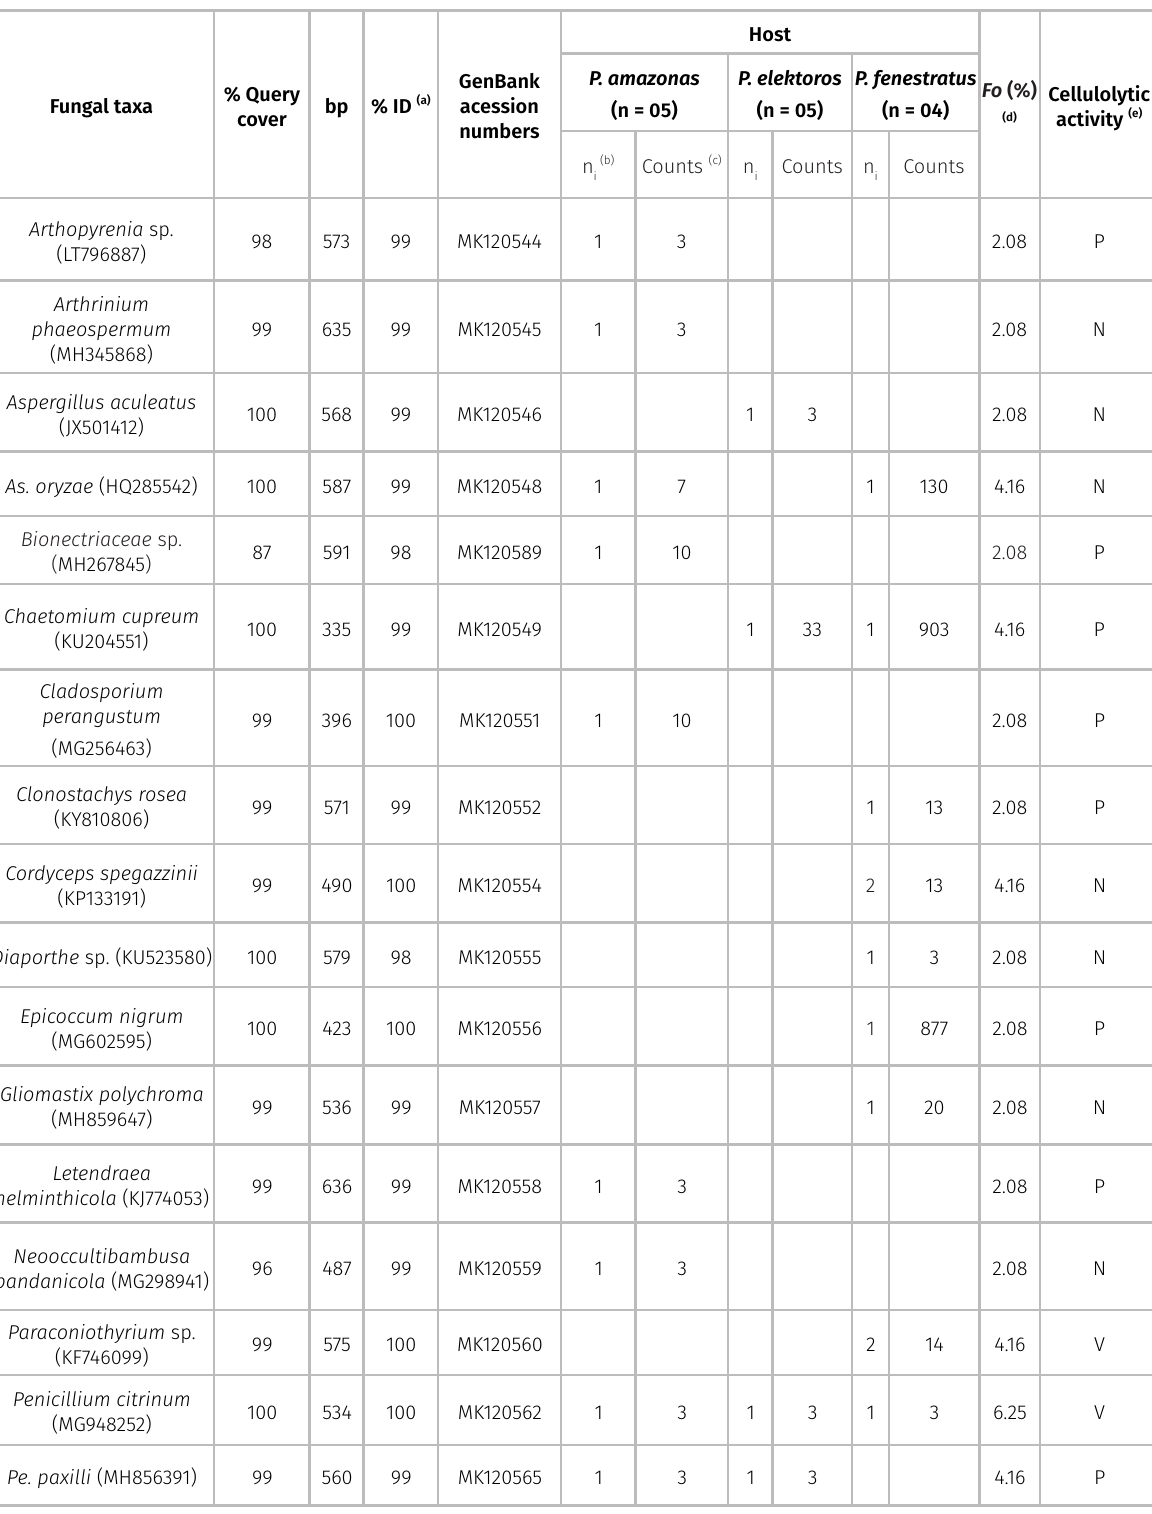
Table I. Identification, frequency of occurrence ( Fo ) and cellulolytic activity of fungal taxa isolated from the digestive tract of Phylloicus spp. (Trichoptera: Calamoceratidae) from Amazon Forest, Brazil.